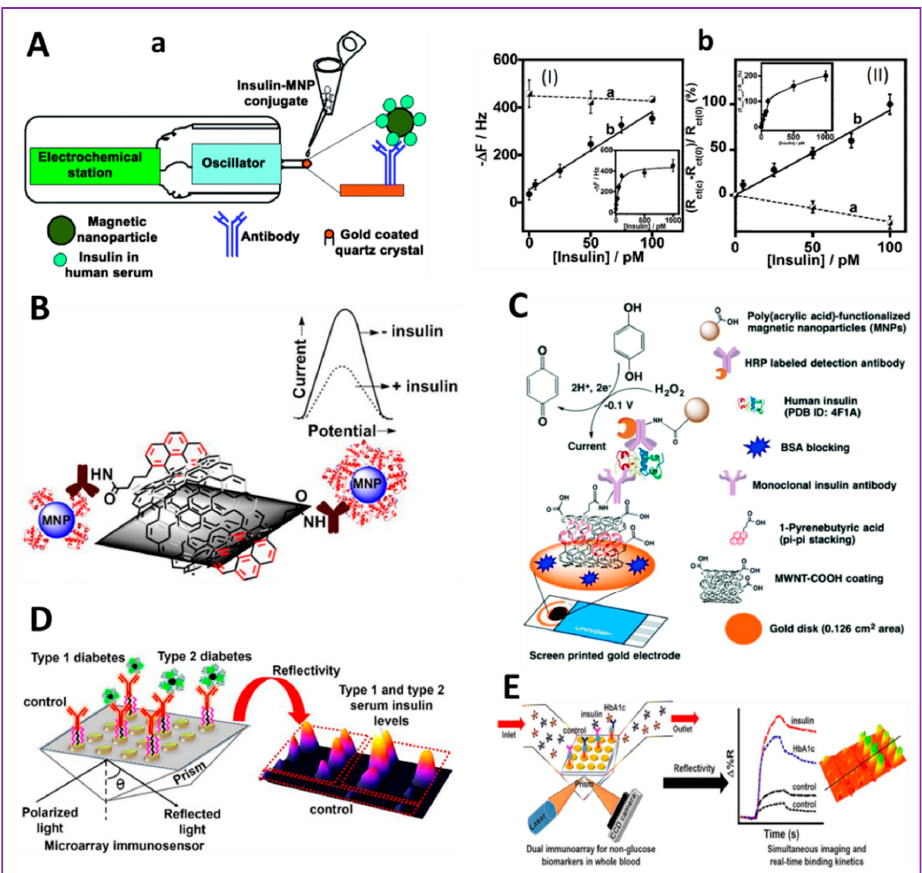
Figure 3. ( A ) An electrochemical mass sensor for clinically relevant detection of insulin in human serum conjugated to magnetic nanoparticles and captured onto antibody immobilized gold-coated